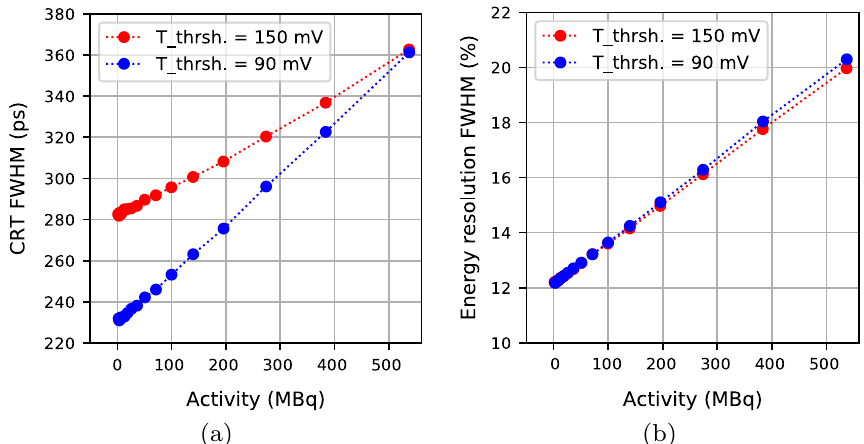
Fig. 4 a Coincidence Resolving Time (CRT) and ( b ) energy resolution versus activity in the mouse scatter phantom